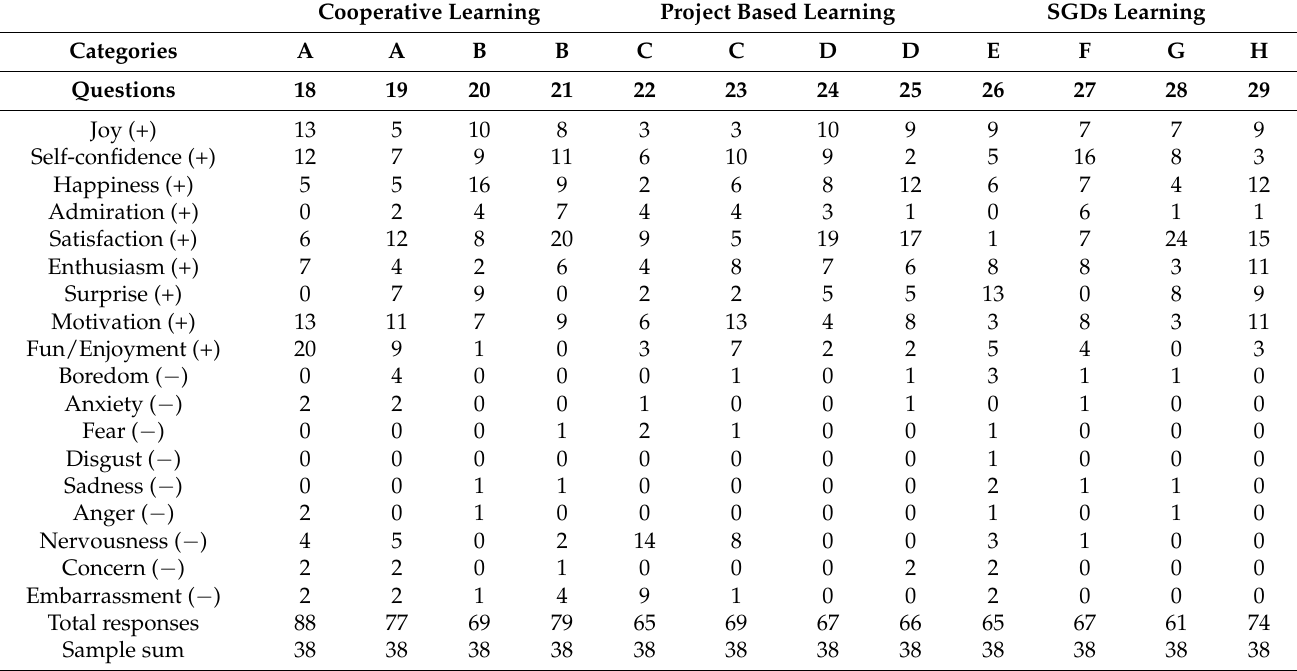
Table 2. Absolute frequencies of responses on active